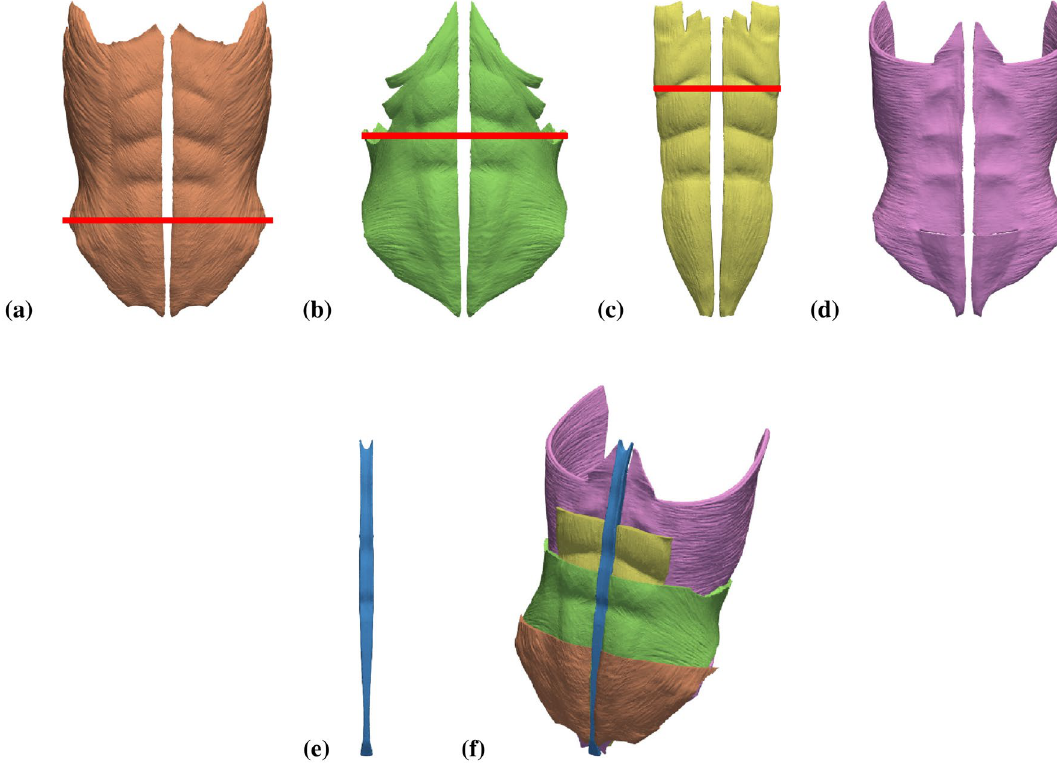
Figure 1. Geometry model of the abdominal wall. The elements included in the model are: ( a ) right and left external oblique muscles (EO), ( b ) right and left internal oblique muscles (IO), ( c ) right and left rectus abdominis muscles (RA), ( d ) right and left transverse abdominis muscles (TR), and ( e ) linea alba (LA). ( f ) View of the whole model; note that muscle regions above the red lines in parts ( a )–( c ) were removed from the plot and that since the muscles are superimposed the surfaces of the remaining (non-removed) muscle regions are only partially visible in the composed